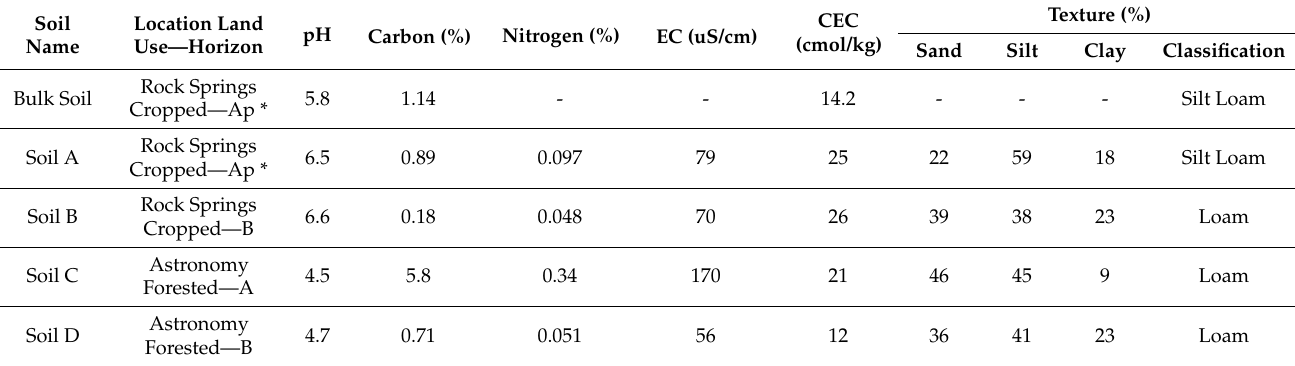
Table 2. Properties of the soils used in the methodology development for the extraction of sul- famethoxazole, trimethoprim, lincomycin, and ofloxacin from